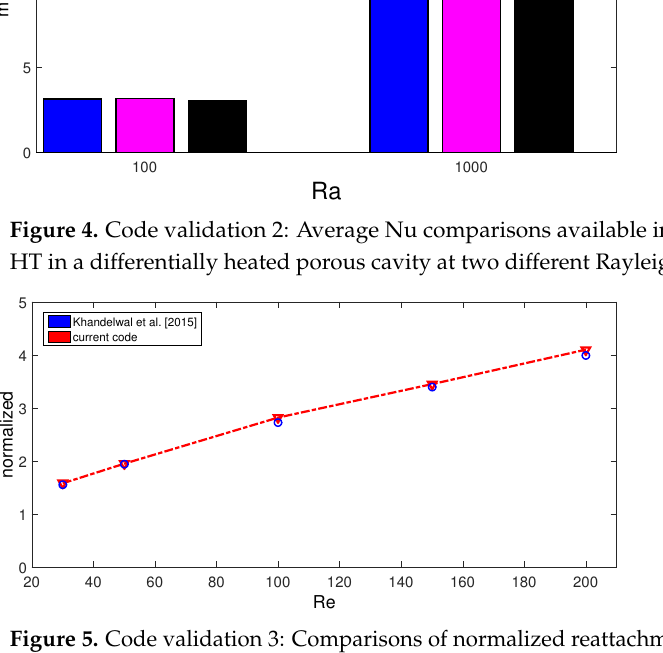
Figure 5. Code validation 3: Comparisons of normalized reattachment length for different Re for the flow in a T-branching channel by using the results in Ref.